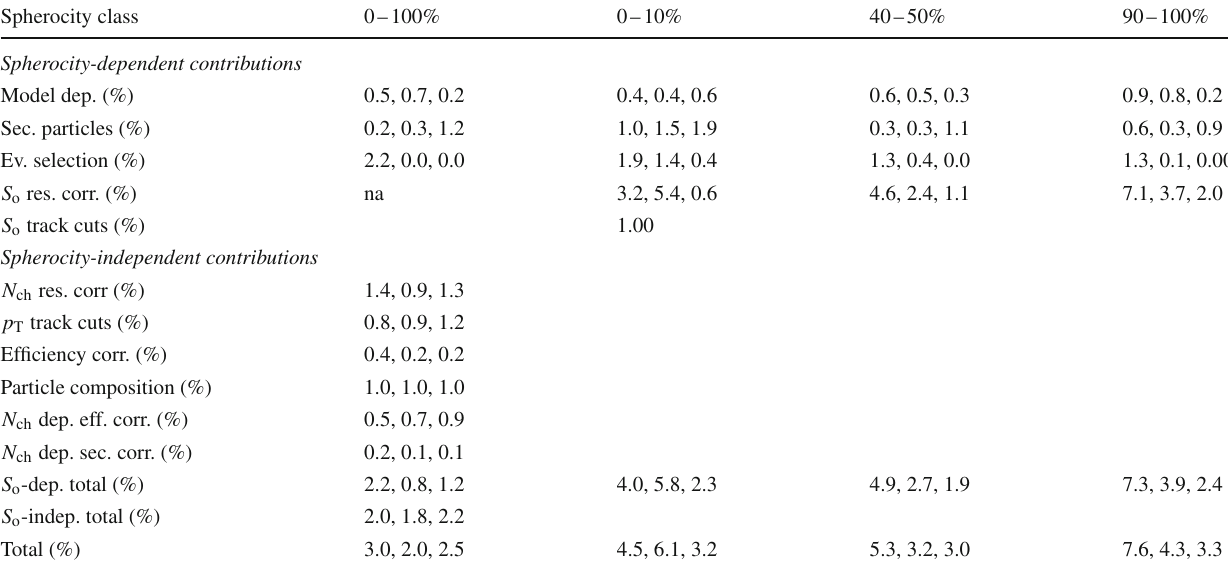
Table 4 Main sources and values of the relative systematic uncertainties on the average p T for different spherocity classes. The three quoted values (for each contribution) correspond to d N ch / d η = 1 . 88, 6.25, and 25.0, respectively Spherocity